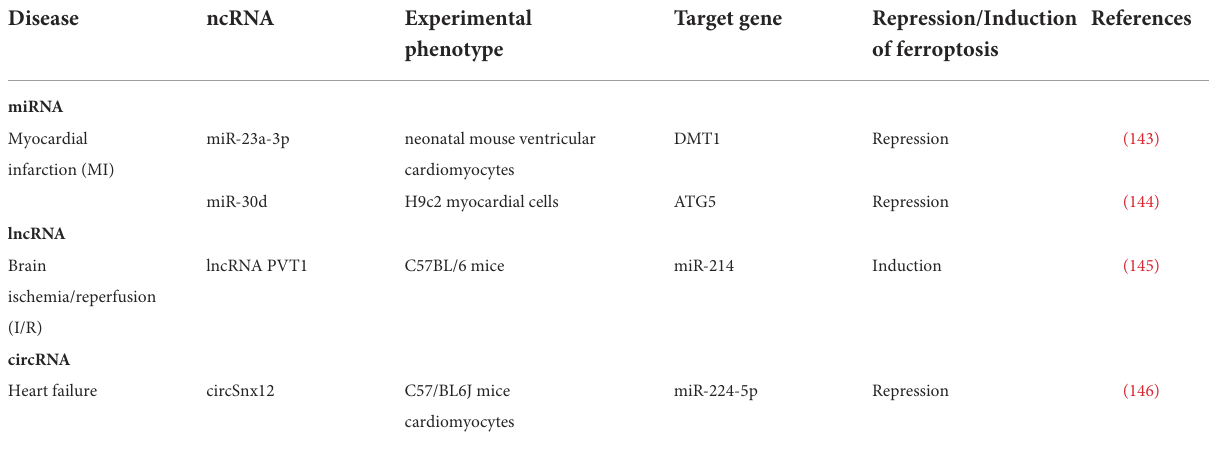
TABLE 3 Non-coding RNAs regulate ferroptosis in various types of CVDs.